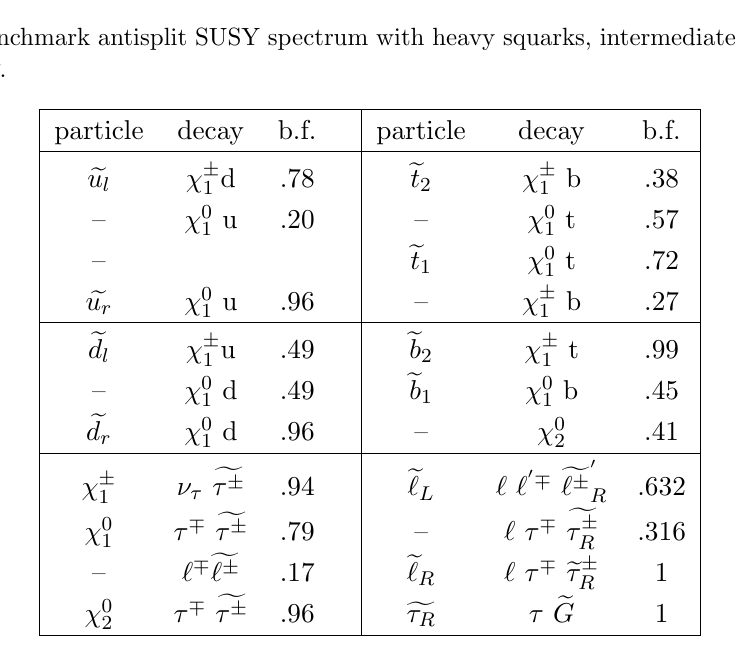
Table 2 . Branching fractions for the most probable decay in a model with mass spectrum found in table